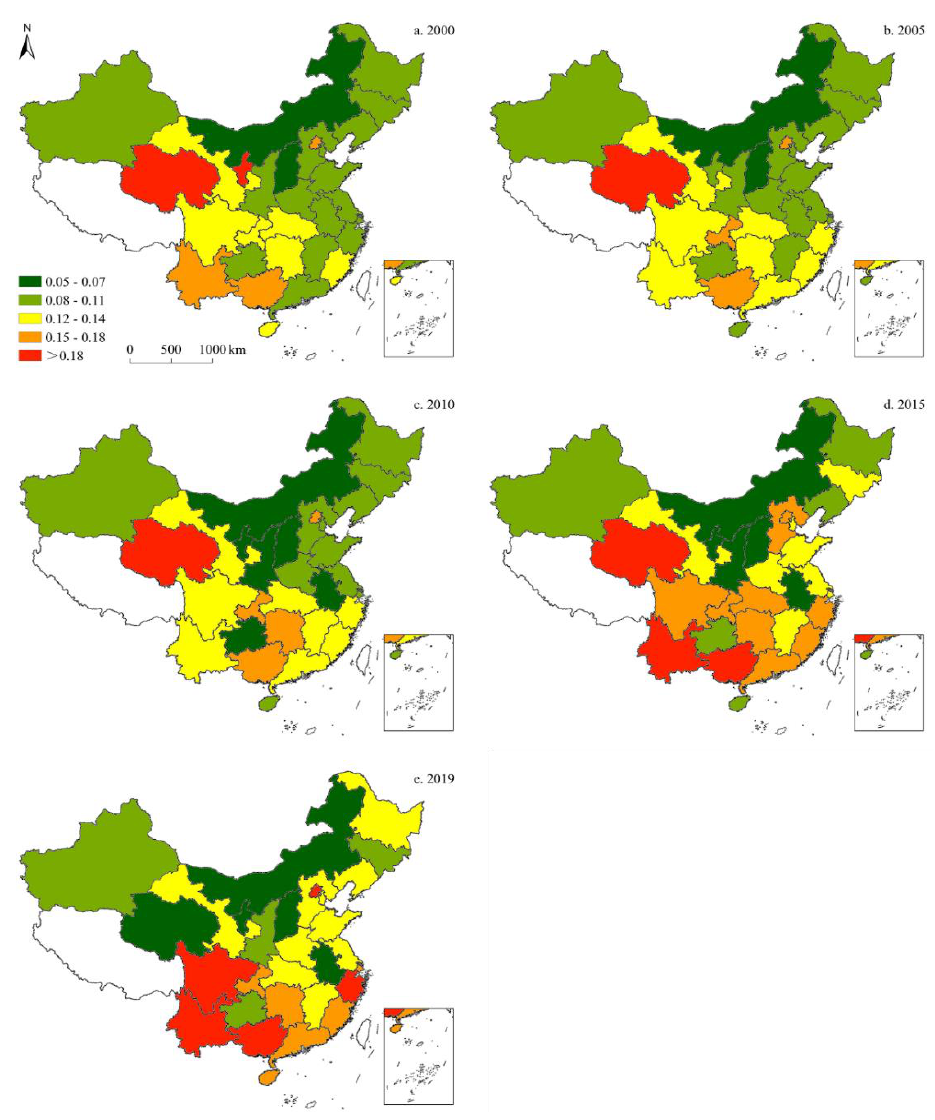
Figure 6. Spatiotemporal distribution of provincial-level non-fossil fuel energy consumption in China (five-time sections).